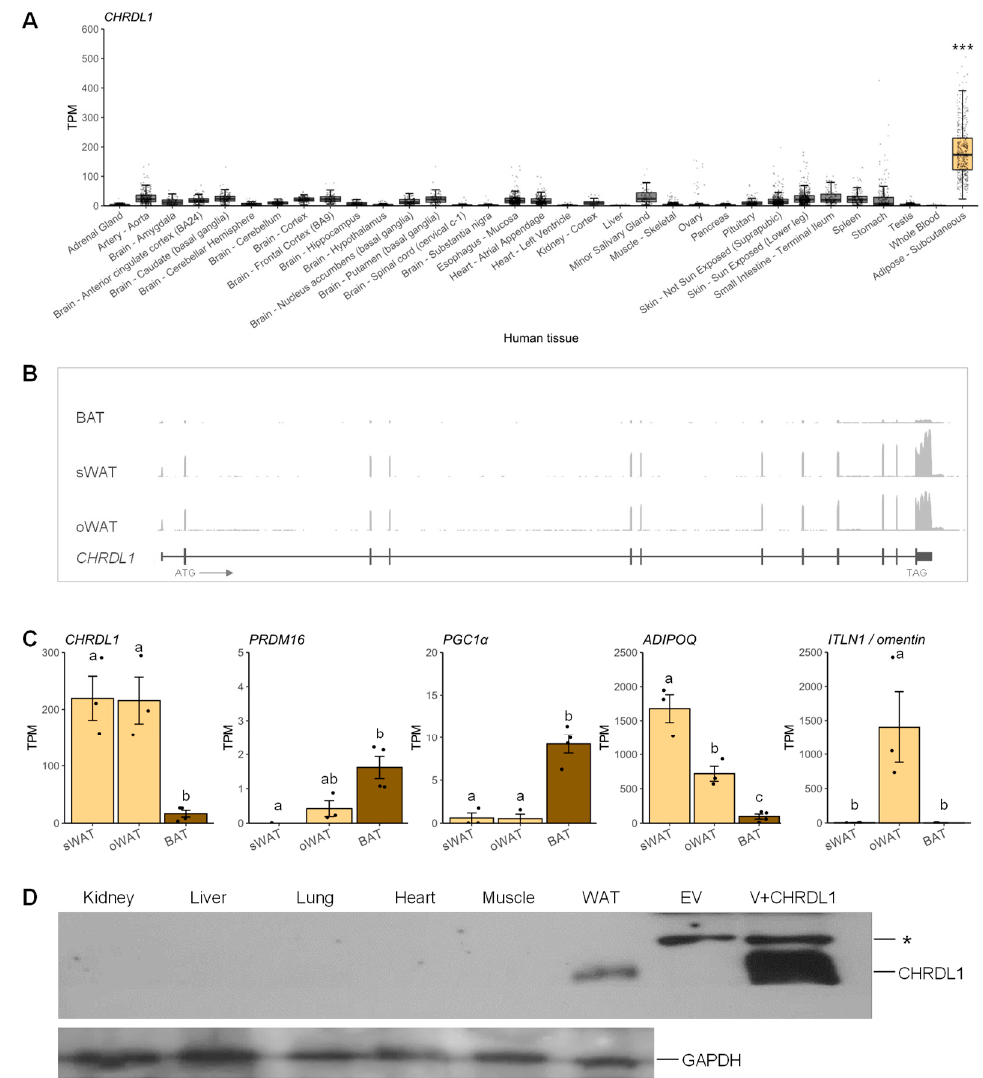
Figure 2. Analysis of CHRDL1 mRNA and CHRDL1 protein expression patterns in human tissues. ( A ) The CHDL1 mRNA expression levels in a variety of human tissues. TPM values are presented as mean ± SEM. ***, p < 0.001. Each data point is displayed in transparent grey dots due to large sample sizes of the GTEx data (Table S3). The interquartile range shows the middle 50% of values.